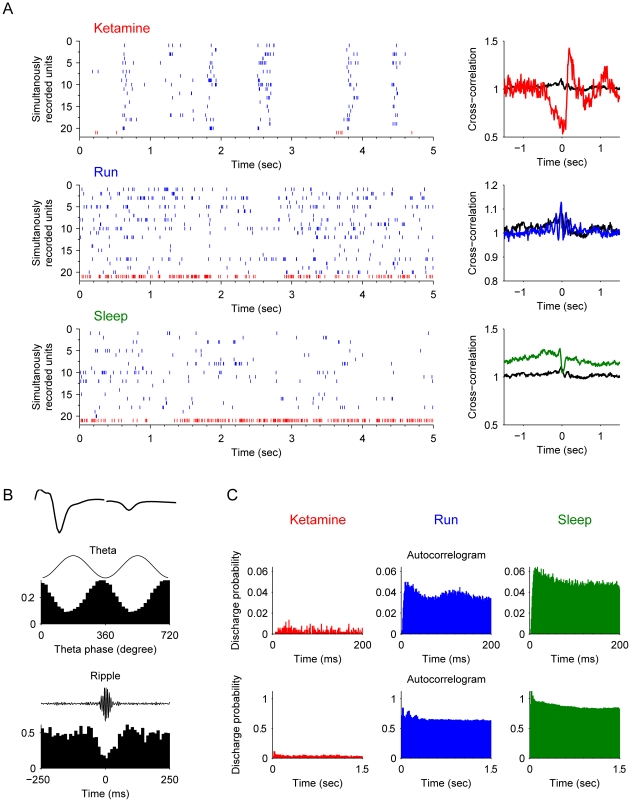
Properties of type-4 interneurons (putative O-LM cell).(A) Spike rasters of the putative O-LM cell (red) and simultaneously recorded pyramidal cells (blue) after ketamine injection, during running and slow-wave sleep are shown (left subpanels). The cross-correlation functions of the interneuron and pyramidal cell joint-activities are plotted on the right. The black line is the cross-correlation during the awake rest state. This unit has negative correlation with pyramidal cells at time 0 in the cross-correlation plot (upper right panel). (B) The basic properties of this O-LM cell. The most upper left panel shows the average spike waveforms. The middle left panel illustrates that this unit has strongly tendency to fire in the valleys of theta oscillations (p<0.001, Rayleigth's test). The lower left panel shows the firing rate is significantly decreased during ripple epochs. (C) Autocorrelograms in different states: after ketamine injection, during running, and during sleep respectively. Autocorrelograms are shown in two time scales: 0–200 ms and 0–1.5 sec.